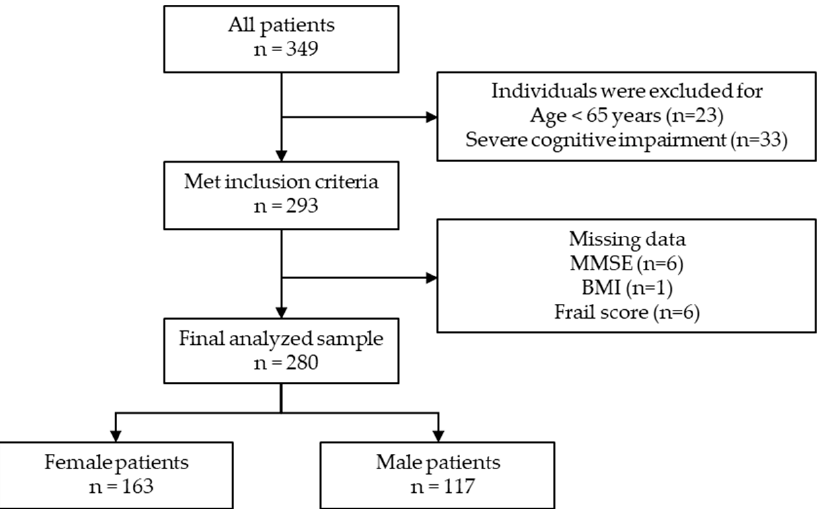
Figure 1. Flow chart of the study sample selection.